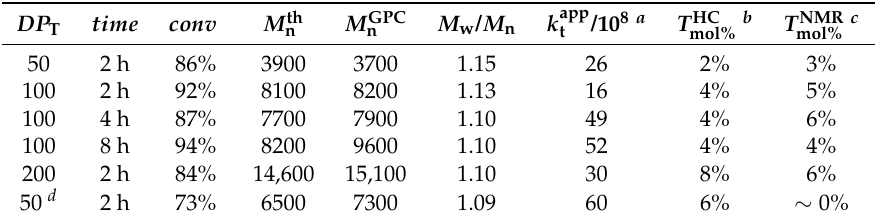
Table 1. ATRP of MA by continuous feeding of